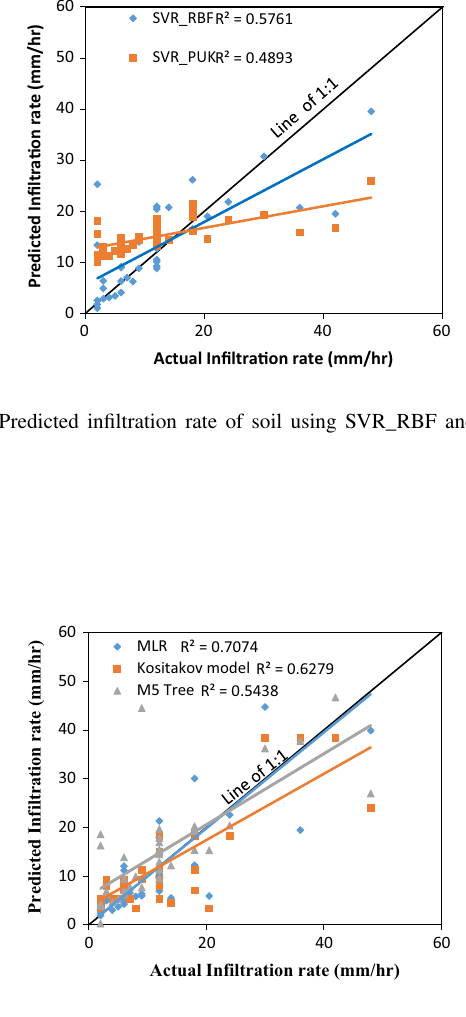
Fig. 5 Predicted infiltration rate of soil by using MLR, M5P tree